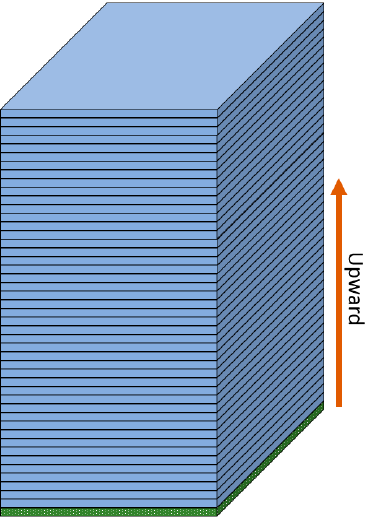
Figure 38. Starting layer (inlet plane) and direction of cascading deployment.